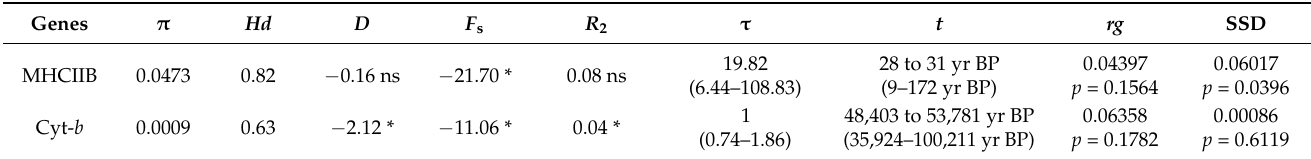
Table 4. Genetic diversity, demographic parameters, and mismatch distributions with goodness of fit for MHCIIB and cytochrome b haplotypes, respectively, were recovered from 68 Heermann’s